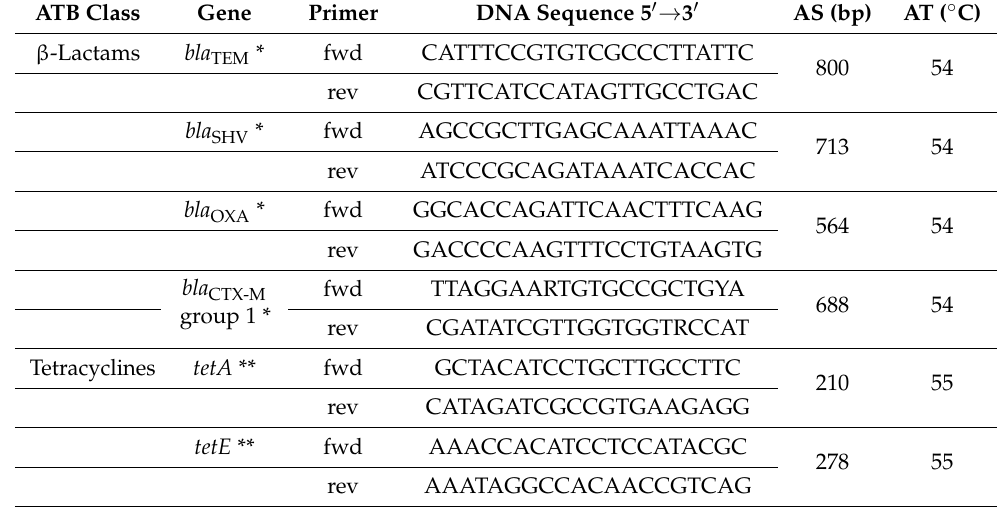
Table 2. Resistant genes detected during PCR in resistant coliform